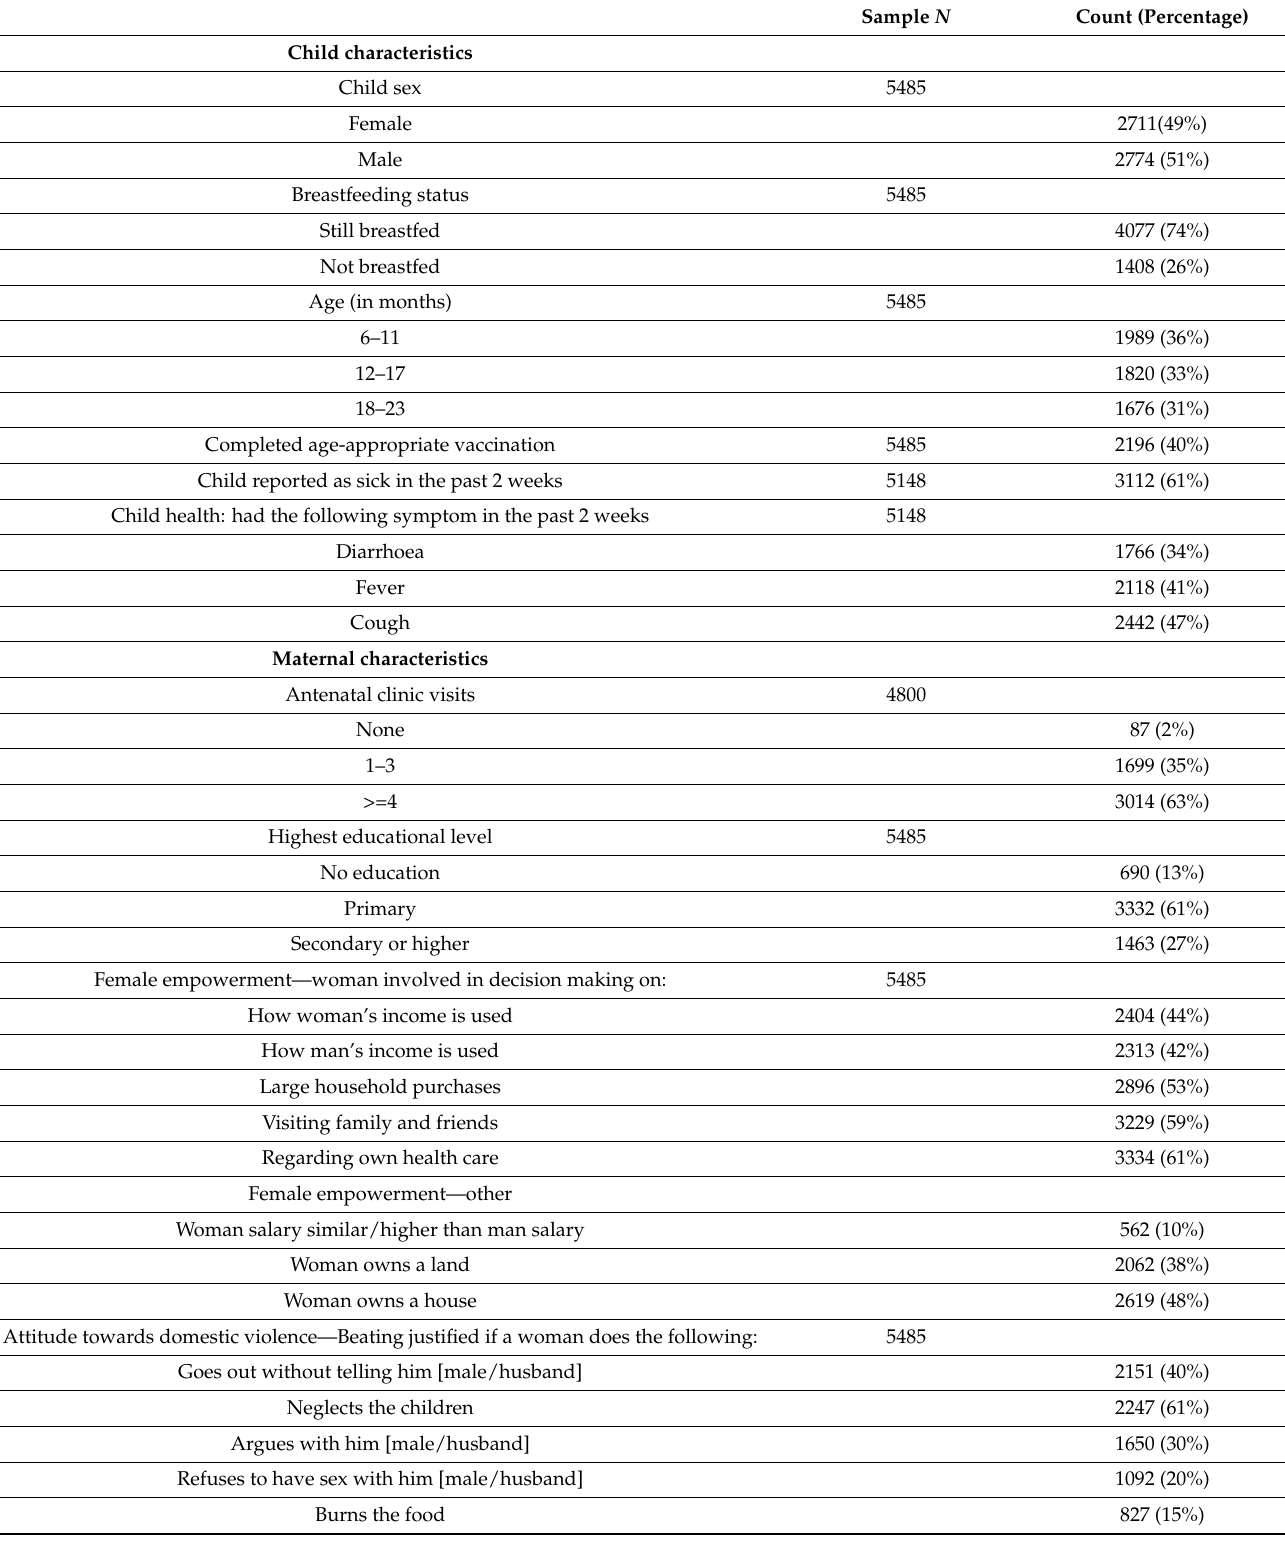
Table 4. Sample characteristics of children aged 6–23 months (UDHS